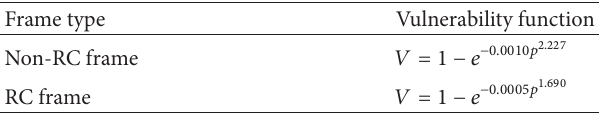
Table 2: Vulnerability functions